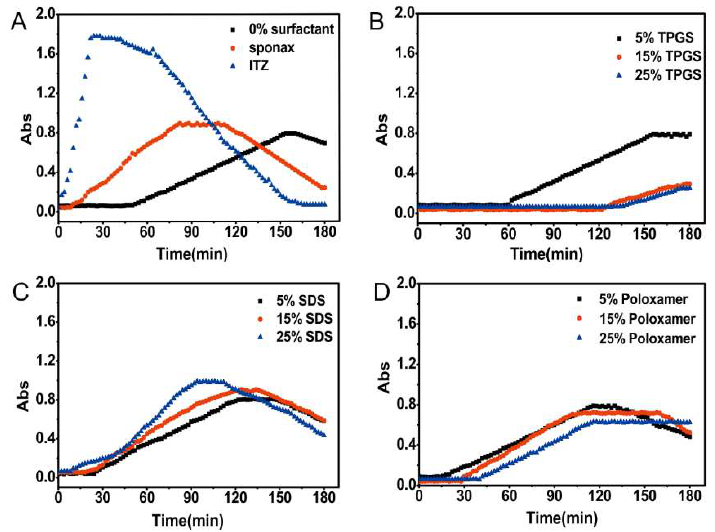
Figure 3. Nucleation induction time for pure ITZ, Sporanox ® , and different formulations in simulated intestinal fluid. ( A ) Nucleation induction time for pure ITZ (itraconazole), Sporanox ® , and ASD (amorphous solid dispersion) without surfactant; Nucleation induction time for ASD with different amount of ( B ) TPGS ( D -α-tocopheryl polyethylene glycol 1000 succinate), ( C ) SDS (sodium dodecyl sulfate), and ( D ) Poloxamer 188.